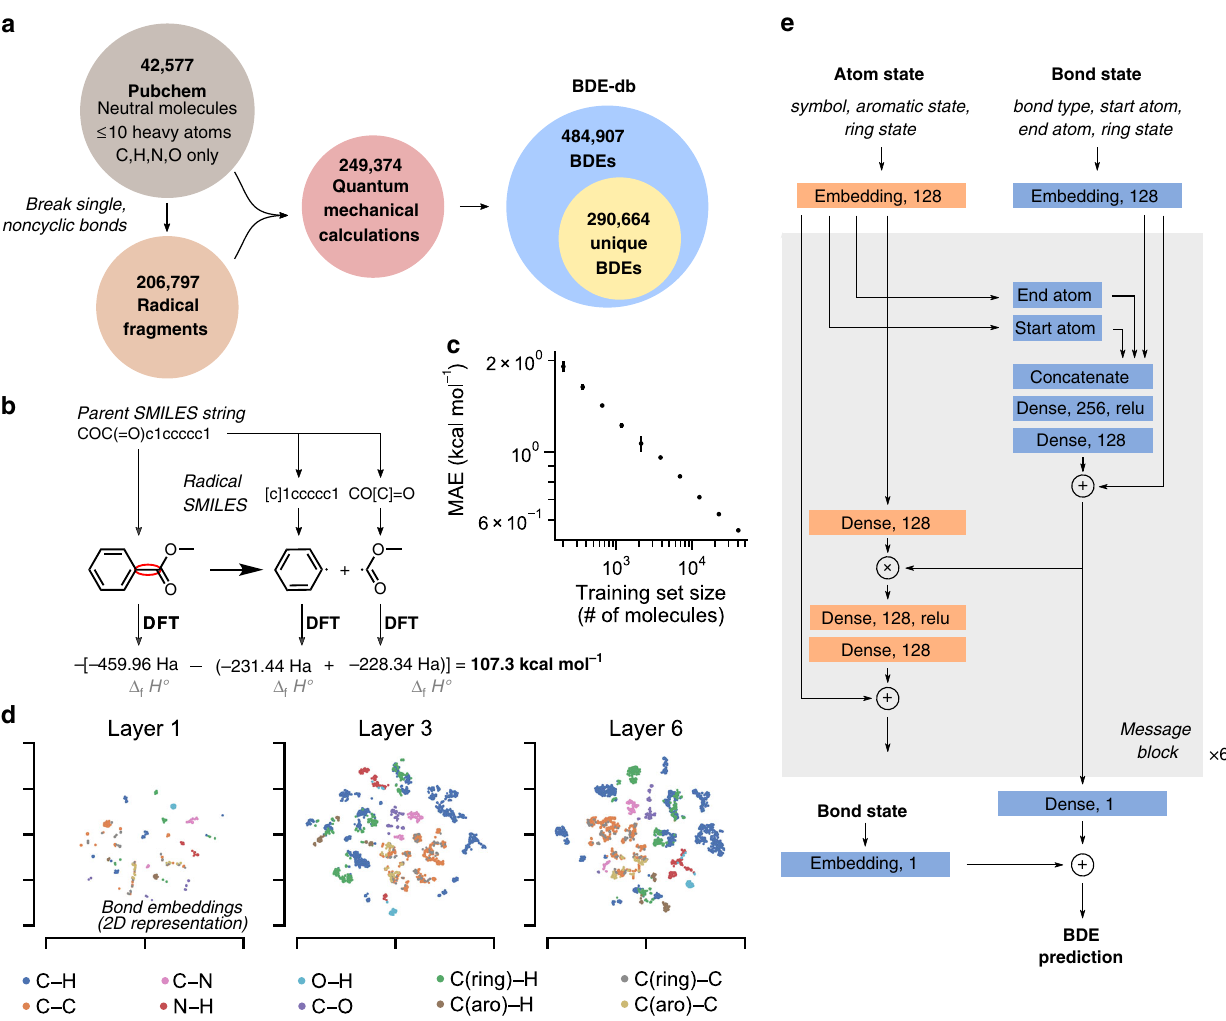
Fig. 2 Overview of database construction and GNN structure. a Size of key elements of BDE-db. b Indexing and calculation of a single BDE reaction. For a given cleaved bond, SMILES strings of the parent molecule and two resulting radicals are passed for DFT optimization. c Learning curve for the model, plotting MAE (in kcal mol − 1 ) on dev set BDEs against the number of molecules included in the training database. Both x and y axes are log-scaled, and error bars indicate standard deviation between three replicates. d 2D representations of bond embeddings are shown via the t-SNE algorithm after the fi rst, third, and fi nal message passing layers. Initially, bonds of similar classes are clustered close together in embedding space. For deeper layers of the model, representations of the bonds become more detailed as they represent its speci fi c local environment. e Structure of the GNN. Atom and bond state vectors are updated through a series of six message passing blocks. The fi nal embedding layer is then used to predict the BDE of each